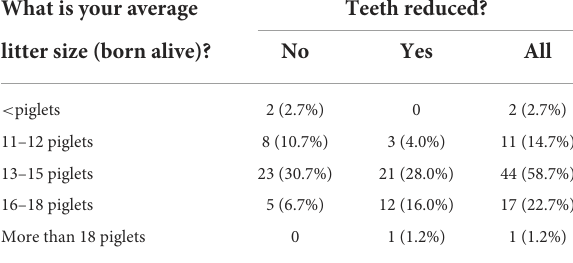
TABLE 7 Reported litter size according to whether or not teeth reduction is currently practiced. What is your average